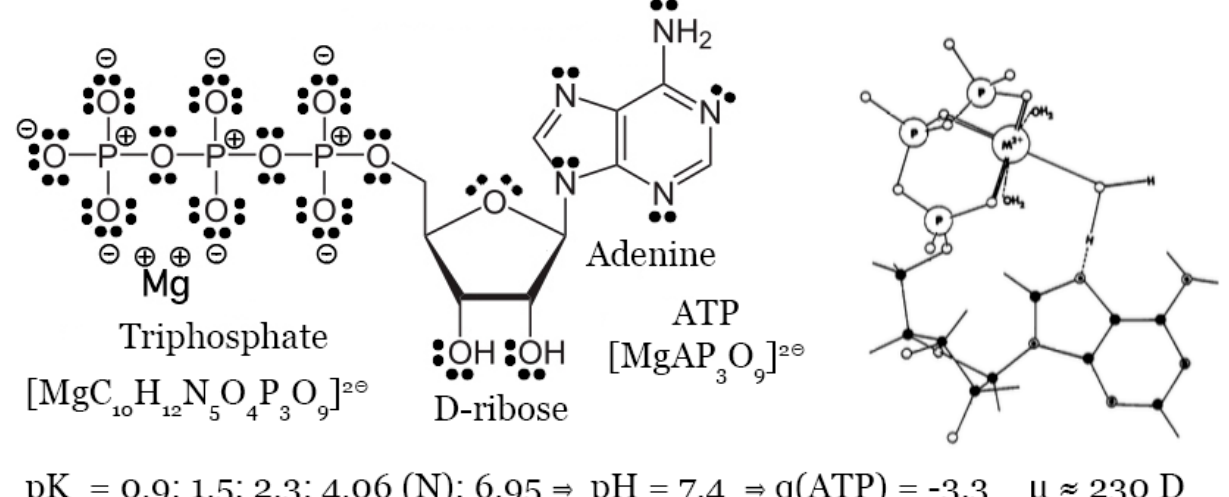
Figure 6. Lewis structure of adenosine triphosphate (ATP) shown here chelating a magnesium